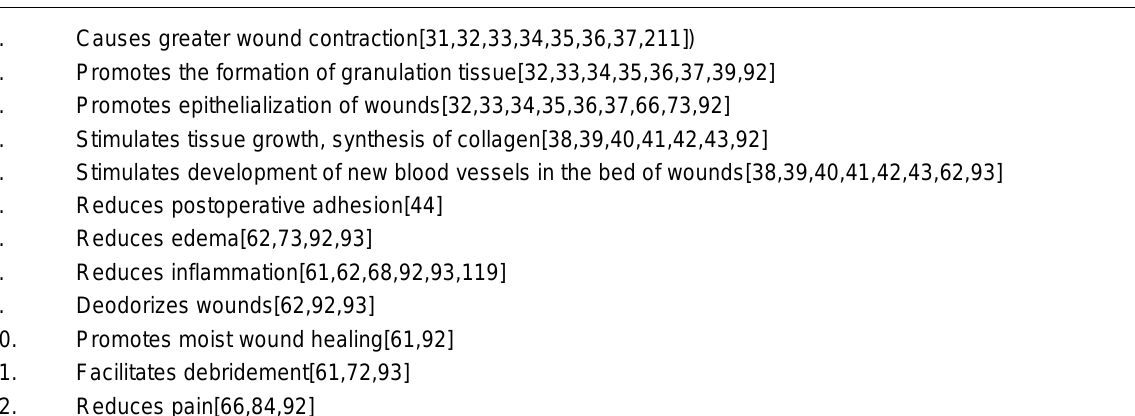
General Effects of Honey on Wound